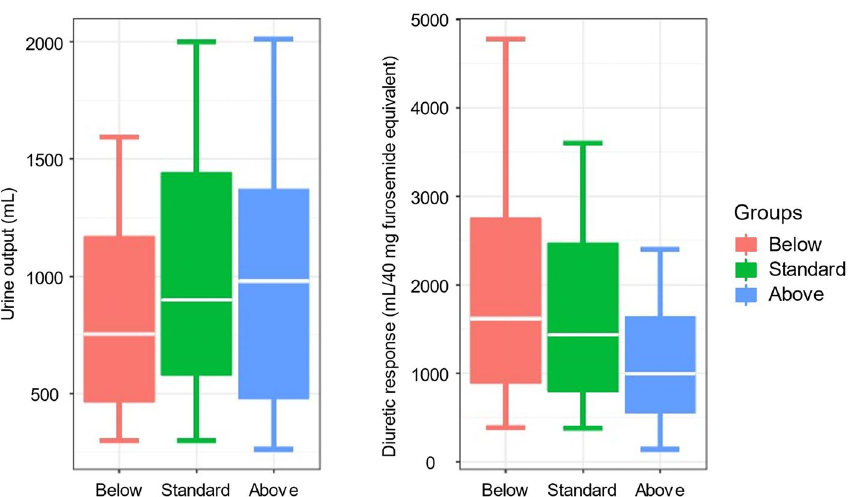
Figure 1. Urine output during the first six hours and diuretic response. Diuretic response was defined as the urine volume during the first six hours per 40 mg of IV furosemide. Although the urine output during the first six hours in the Above group was significantly larger than in the Standard group, its diuretic response was significantly lower ( P < 0.001 for both).